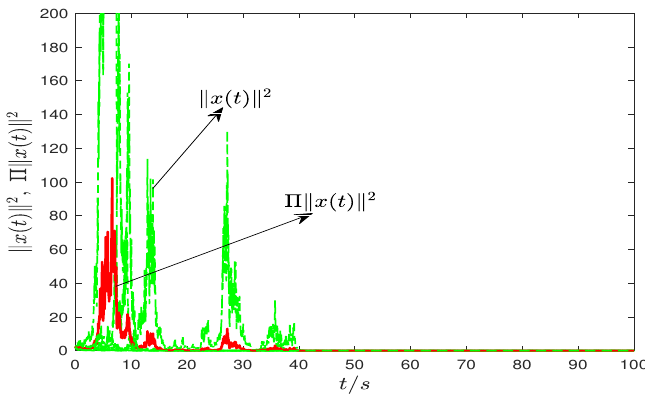
Figure 1. State trajectory curve of open-loop system